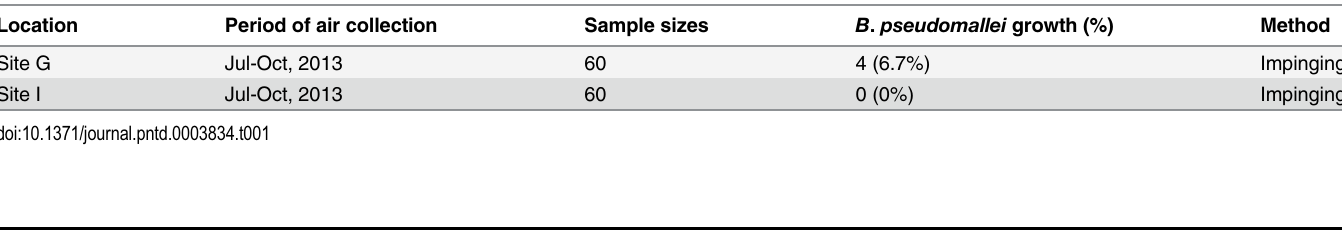
Table 1. Proportion of positive cultures from aerosols in different